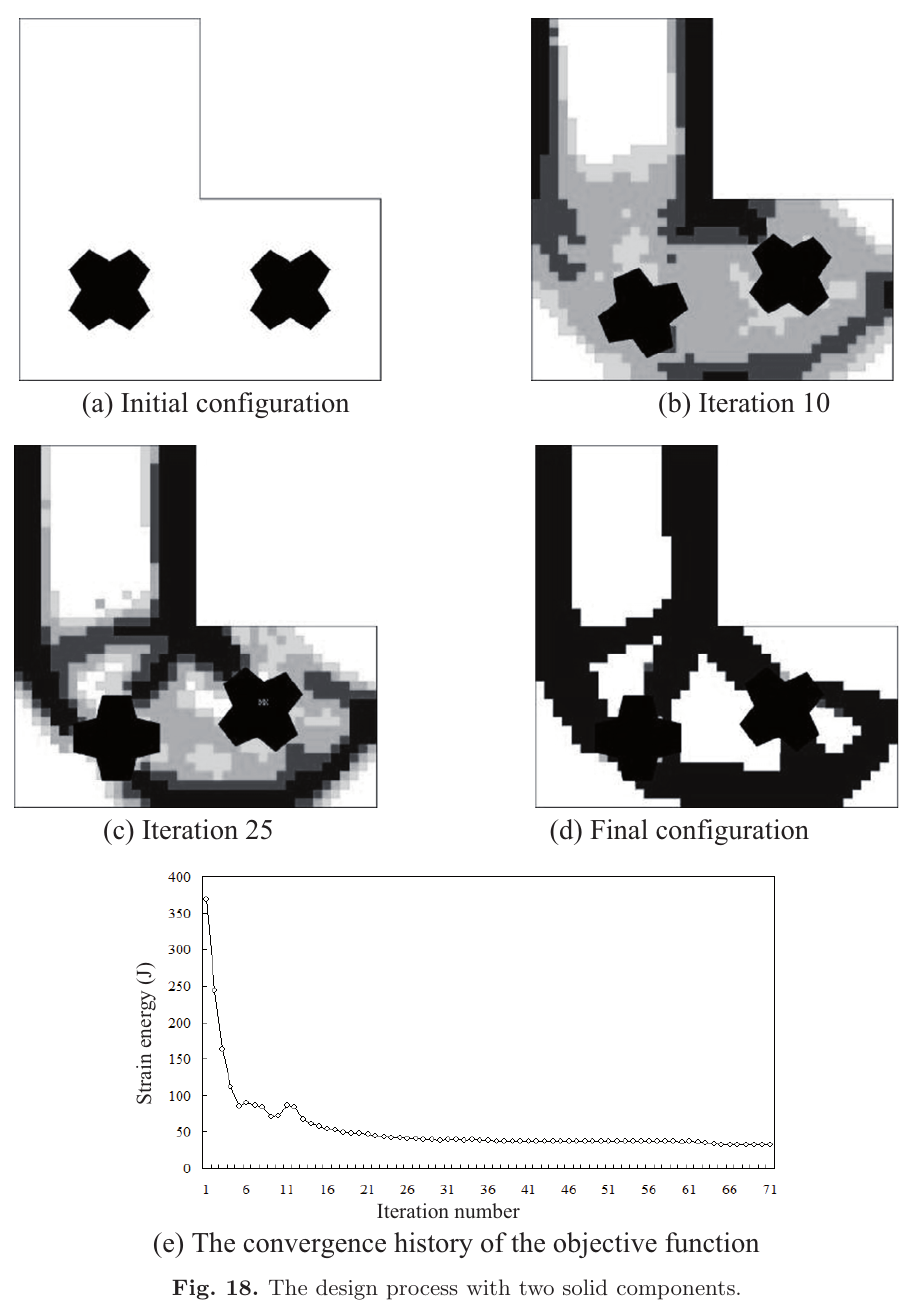
Fig. 18. The design process with two solid